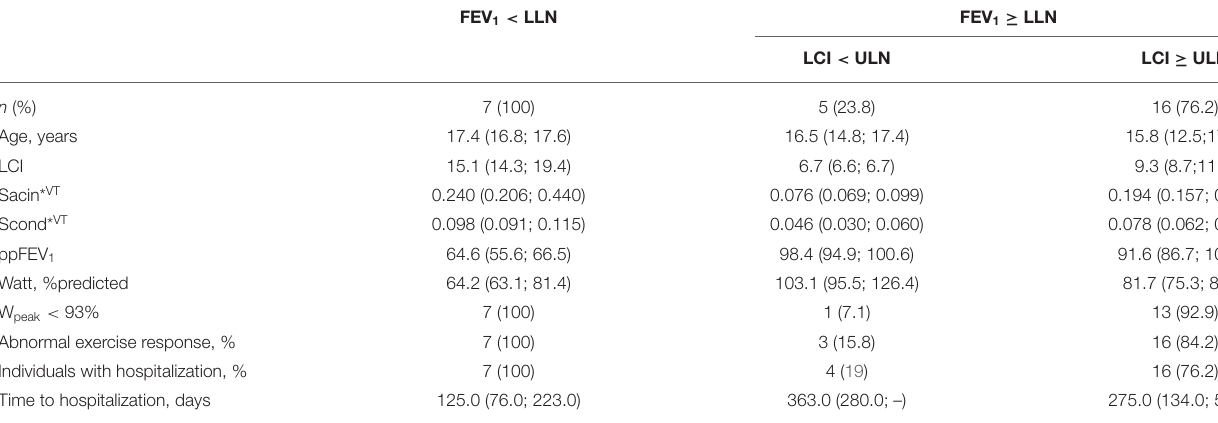
TABLE 2 | Outcomes stratified by FEV 1 LLN.